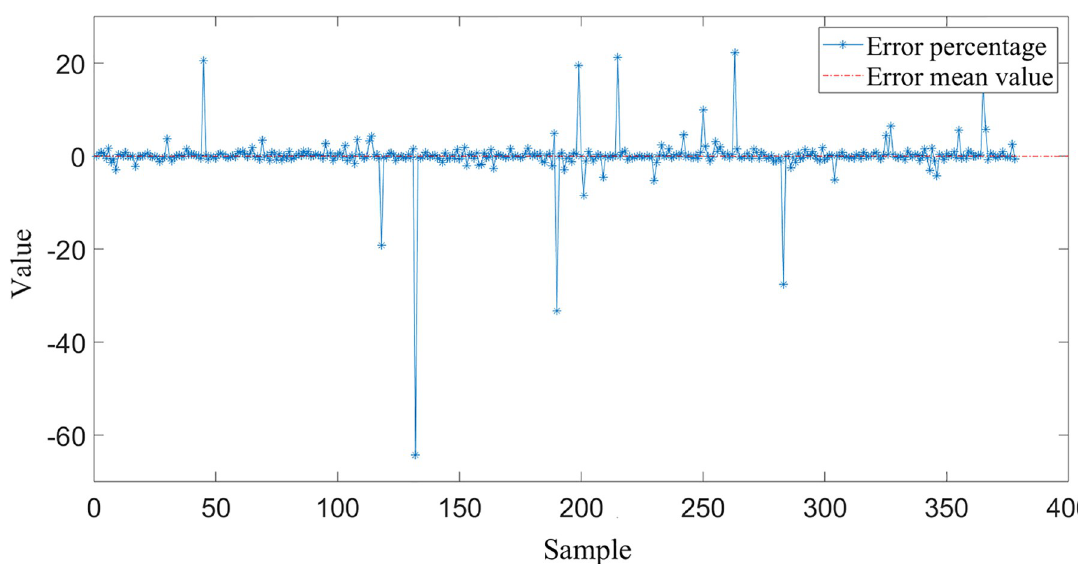
Fig 6. Prediction error percentage of BP neural network.